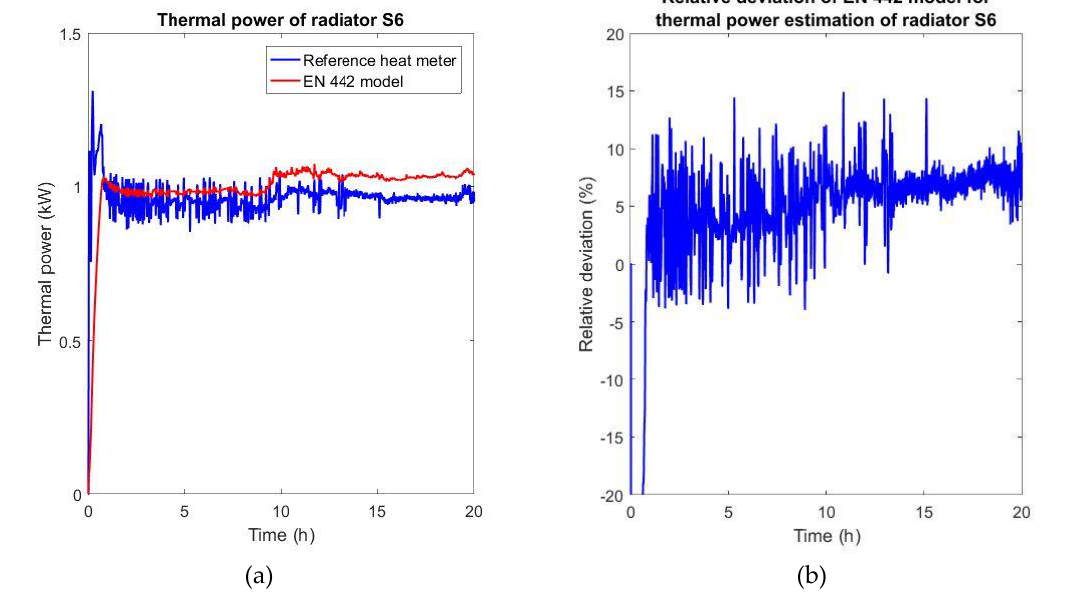
Figure 2. Time evolution of: ( a ) reference thermal power measurement obtained by direct heat metering and indirect thermal power estimation by the EN 442 model for a particular water radiator; ( b ) corresponding relative deviation between thermal power estimation by the EN 442 model and reference direct heat metering.